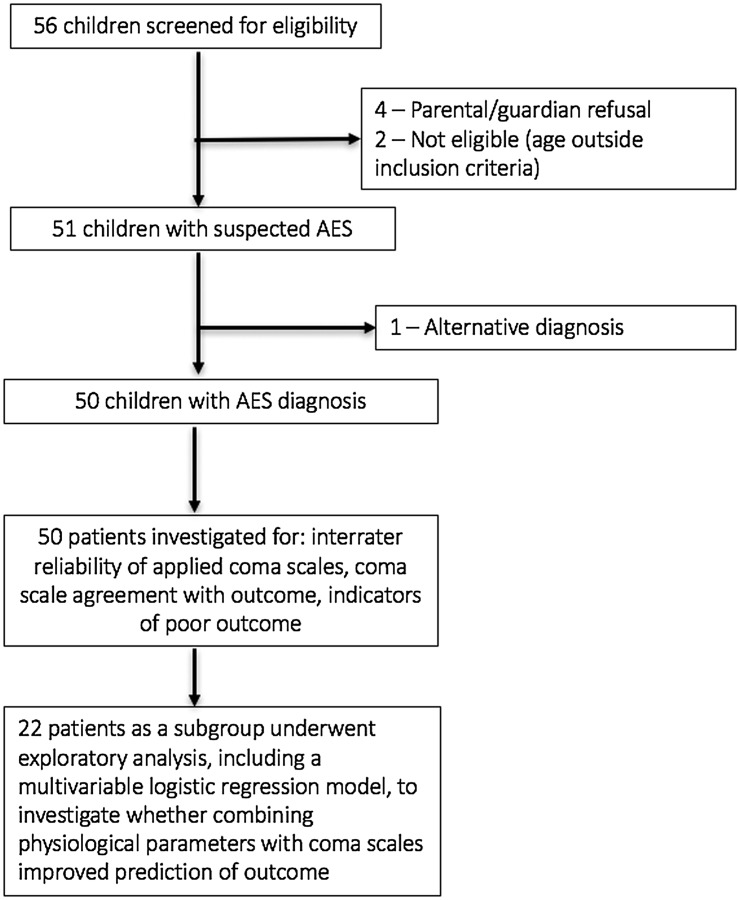
Study flowchart.